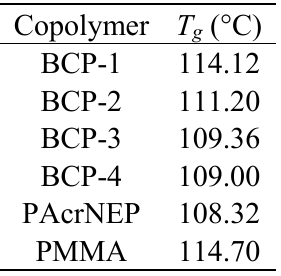
Table 4. Glass transition temperature of the